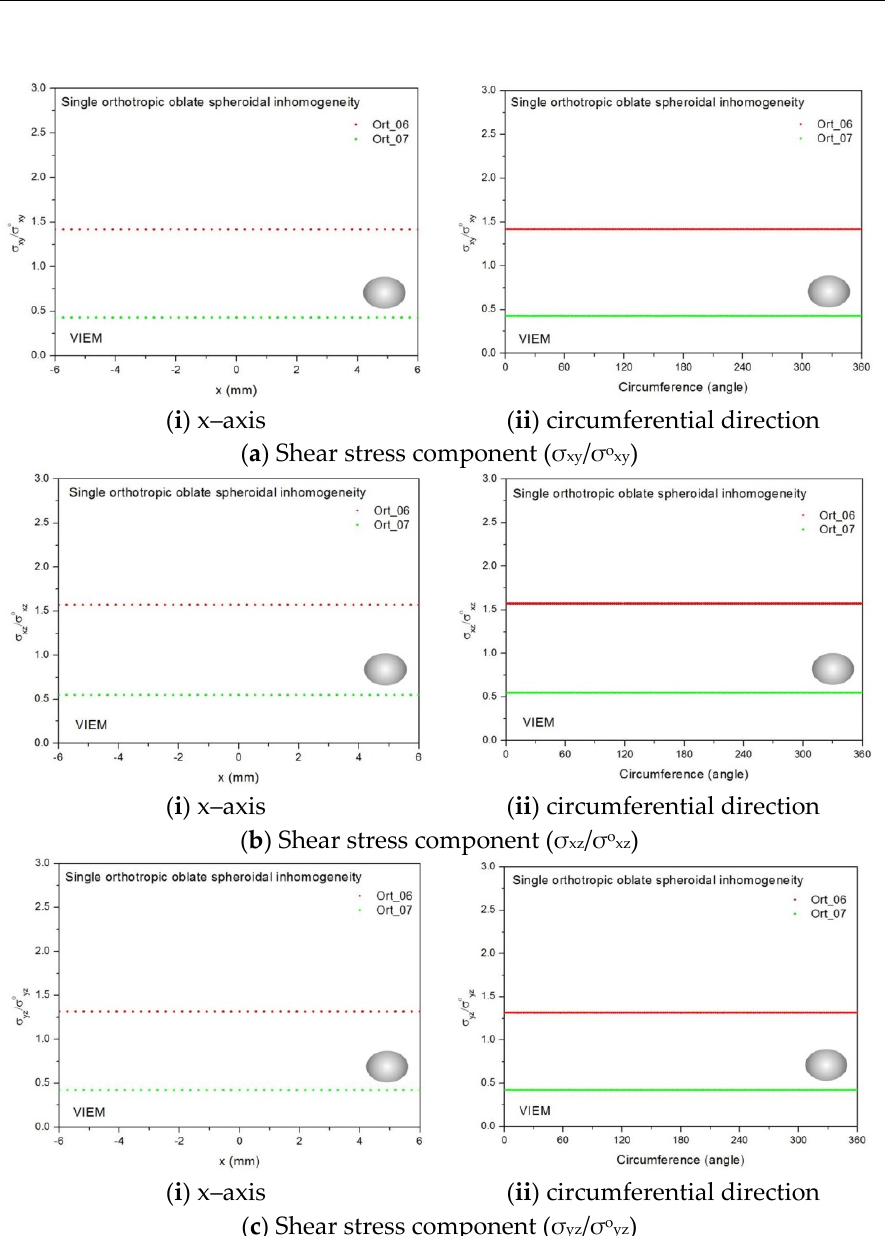
Figure 32. VIEM results for the normalized shear stress components ( a ) σ xy / σ oxy , ( b ) σ xz / σ oxz and ( c ) σ yz / σ o yz along ( i ) the x–axis inside and ( ii ) the circumferential direction of the orthotropic oblate spheroidal inclusions (Ort_06 and Ort_07) with b/a = c/a = 0.75 (a = 6 mm) under remote shear loading ( σ oxy , σ oxz and σ oyz ).